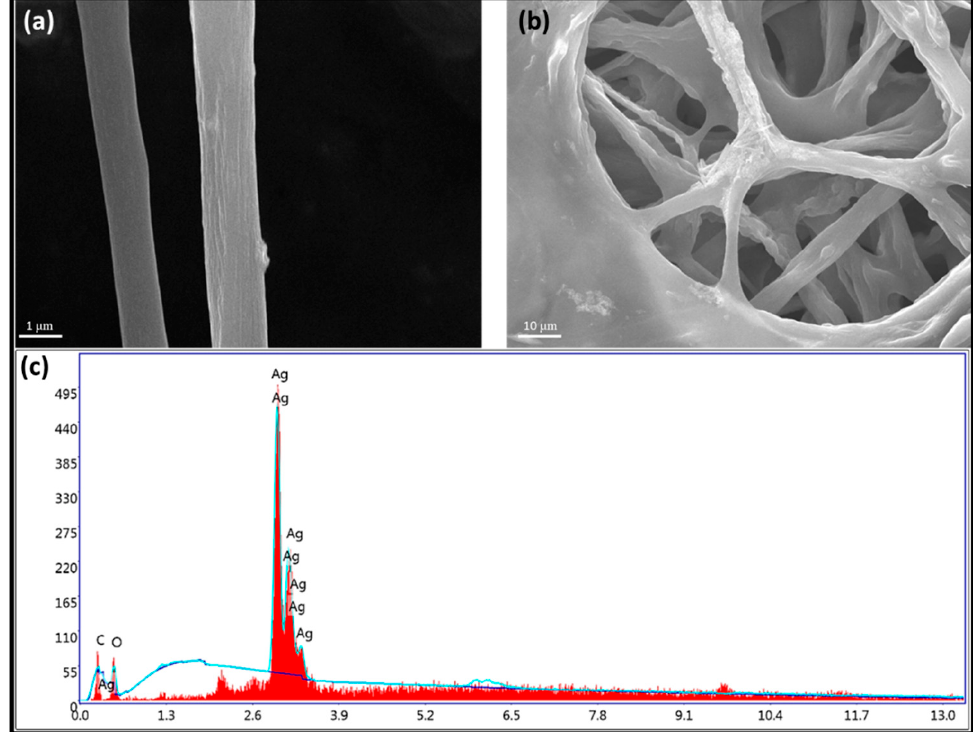
Figure 2. SEM image of FH-AgNP composite: ( a ) 1 μ m magnification; ( b ) 10 μ m magnification. ( c ) Elemental analysis of FH-AgNP composite.